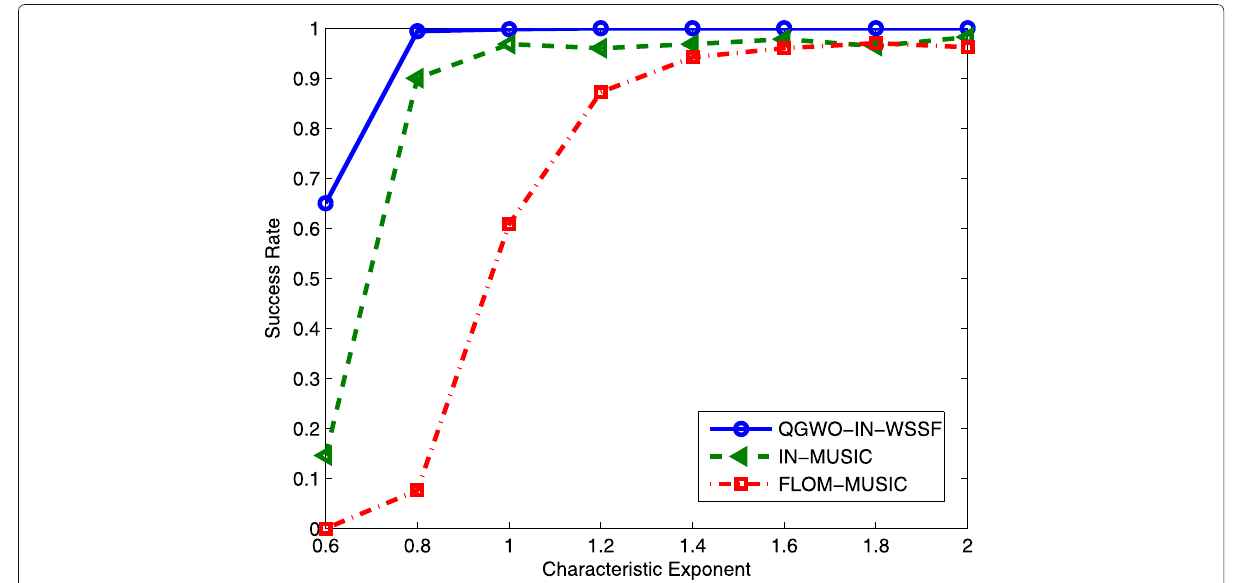
Fig. 7 Success rate curves versus characteristic exponent for two different independent sources with GSNR = 20dB